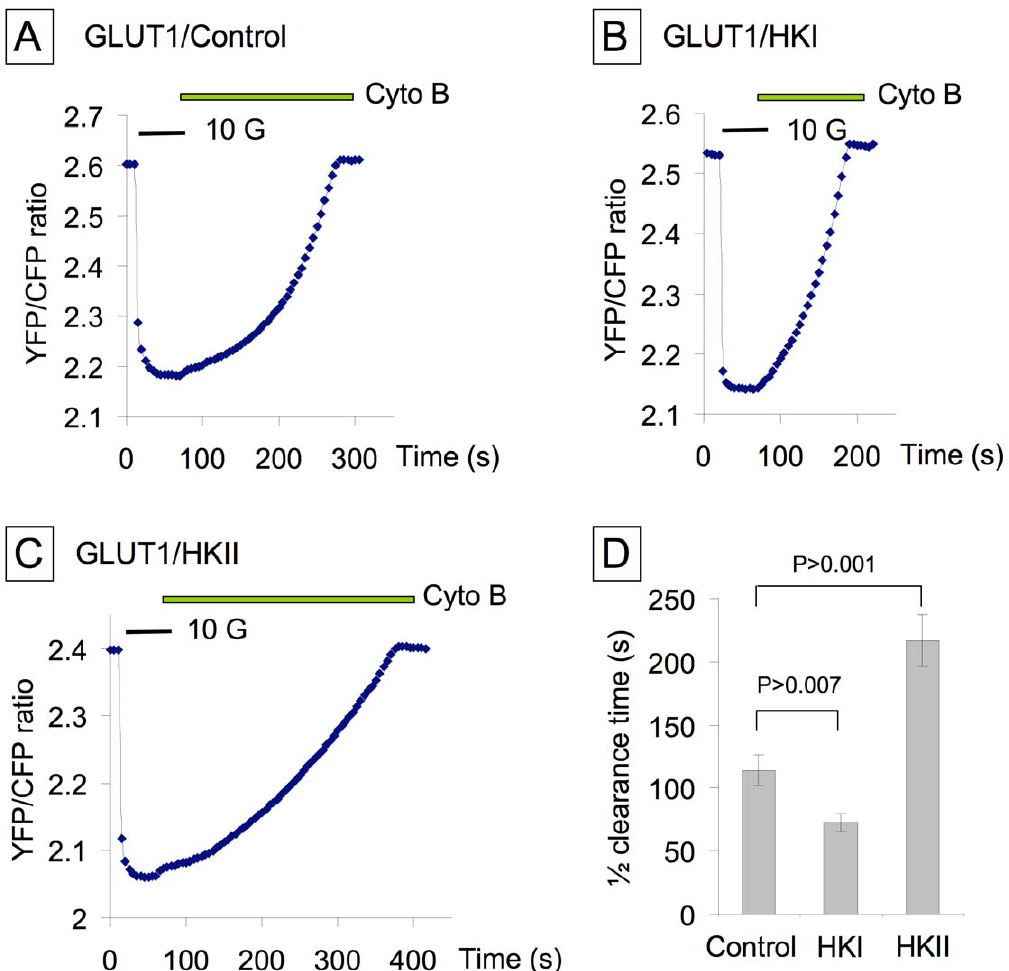
Figure 2. Effects of HKI and HKII on glucose utilization in CHO cells. These data illustrates how overexpression of HKI (Panel B) and HKII (Panel C) affects glucose clearance measured in the presence of CytoB. Comparison of A and B indicates that HKI increases the rate of glucose clearance and thus metabolism, while comparison of A and C demonstrates that HKII has the opposite effect and decreases this rate. Panel E and F show images similar to those in Fig. 1, which illustrate once more the interaction of HKI-YFP with mitochondria and the differential distribution of HKII-YFP, these differential distribution can be correlated with the glucose clearance data in B and C, respectively. The bar graph in D quantifies these